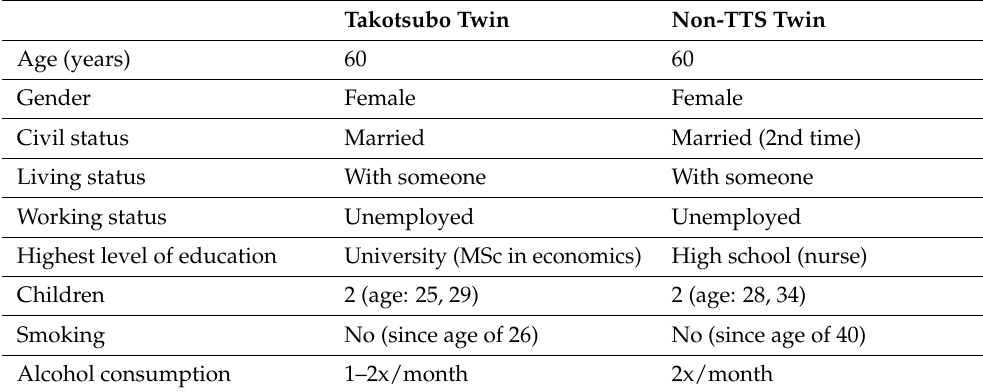
Table 1. Characteristics of the monozygotic twins with and without